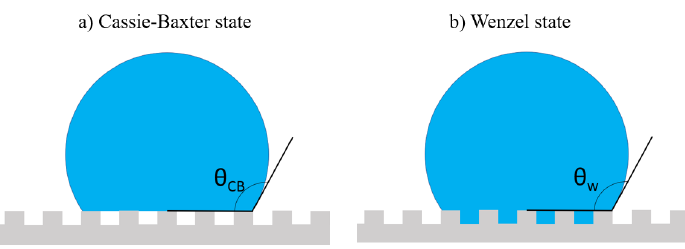
Figure 5. Wetting regimes of droplet on a solid surface: ( a ) Cassie-Baxter state and ( b ) Wenzel state (reproduced with permission from [4]).